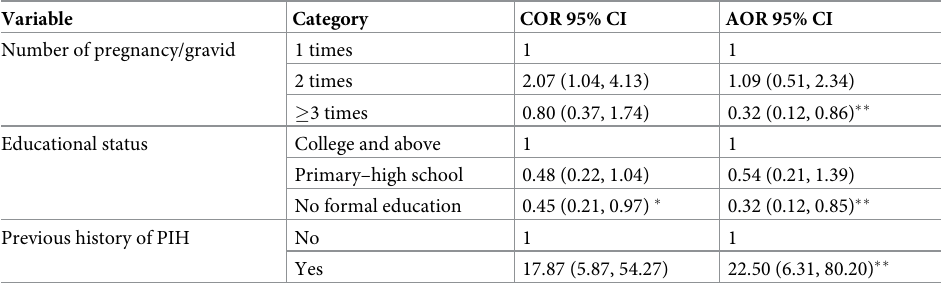
Table 5. Predictors of PIH among women gave birth at Hossana town administration, Southern Ethiopia, 2018.